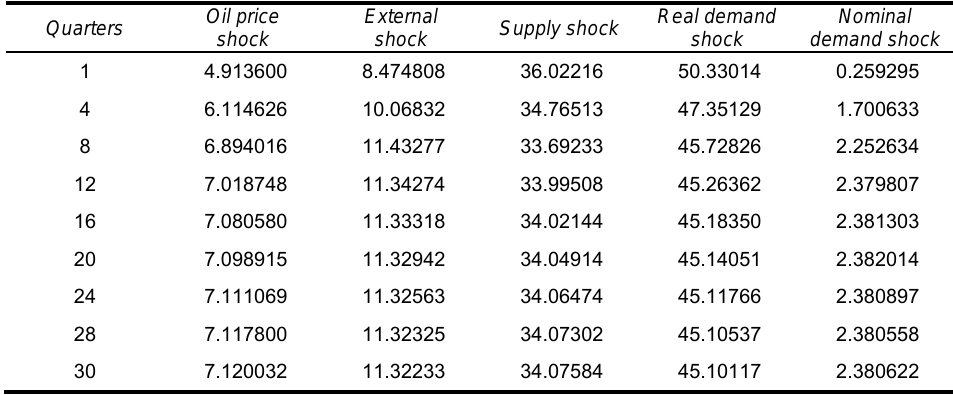
Table 6. The variance decomposition of the foreign exchange rate Quarters